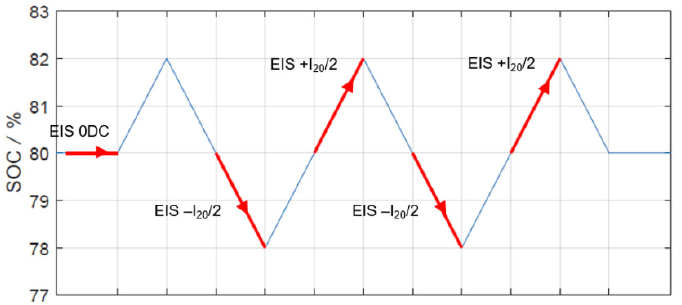
Figure 1. Micro cycles for superimposed current during electrochemical impedance spectrum.